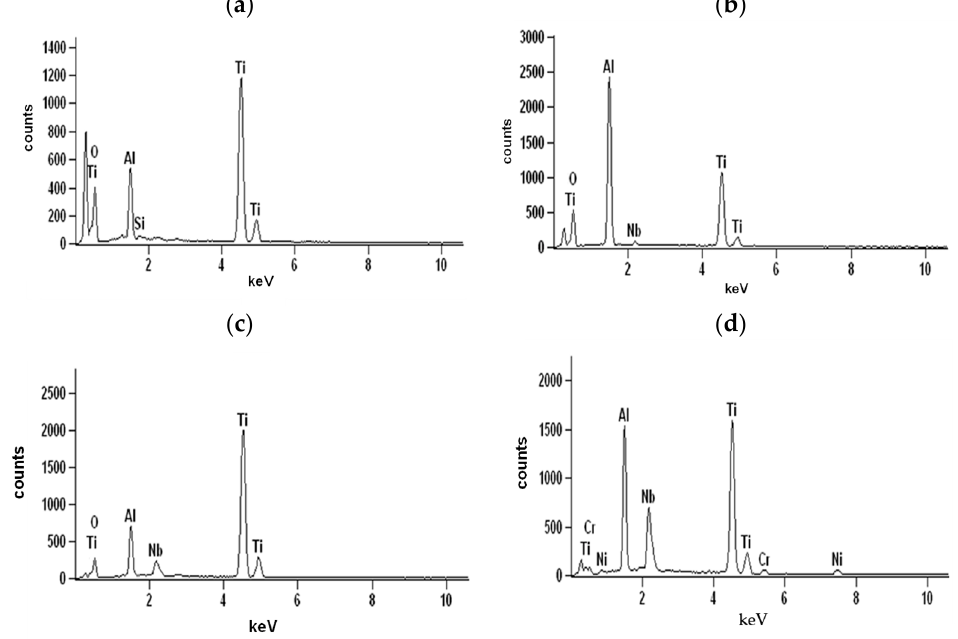
Figure 9. EDS analysis: ( a ) in point 1, ( b ) in point 2, ( c ) in point 3 and ( d ) in point 4 marked in Figure 8b.